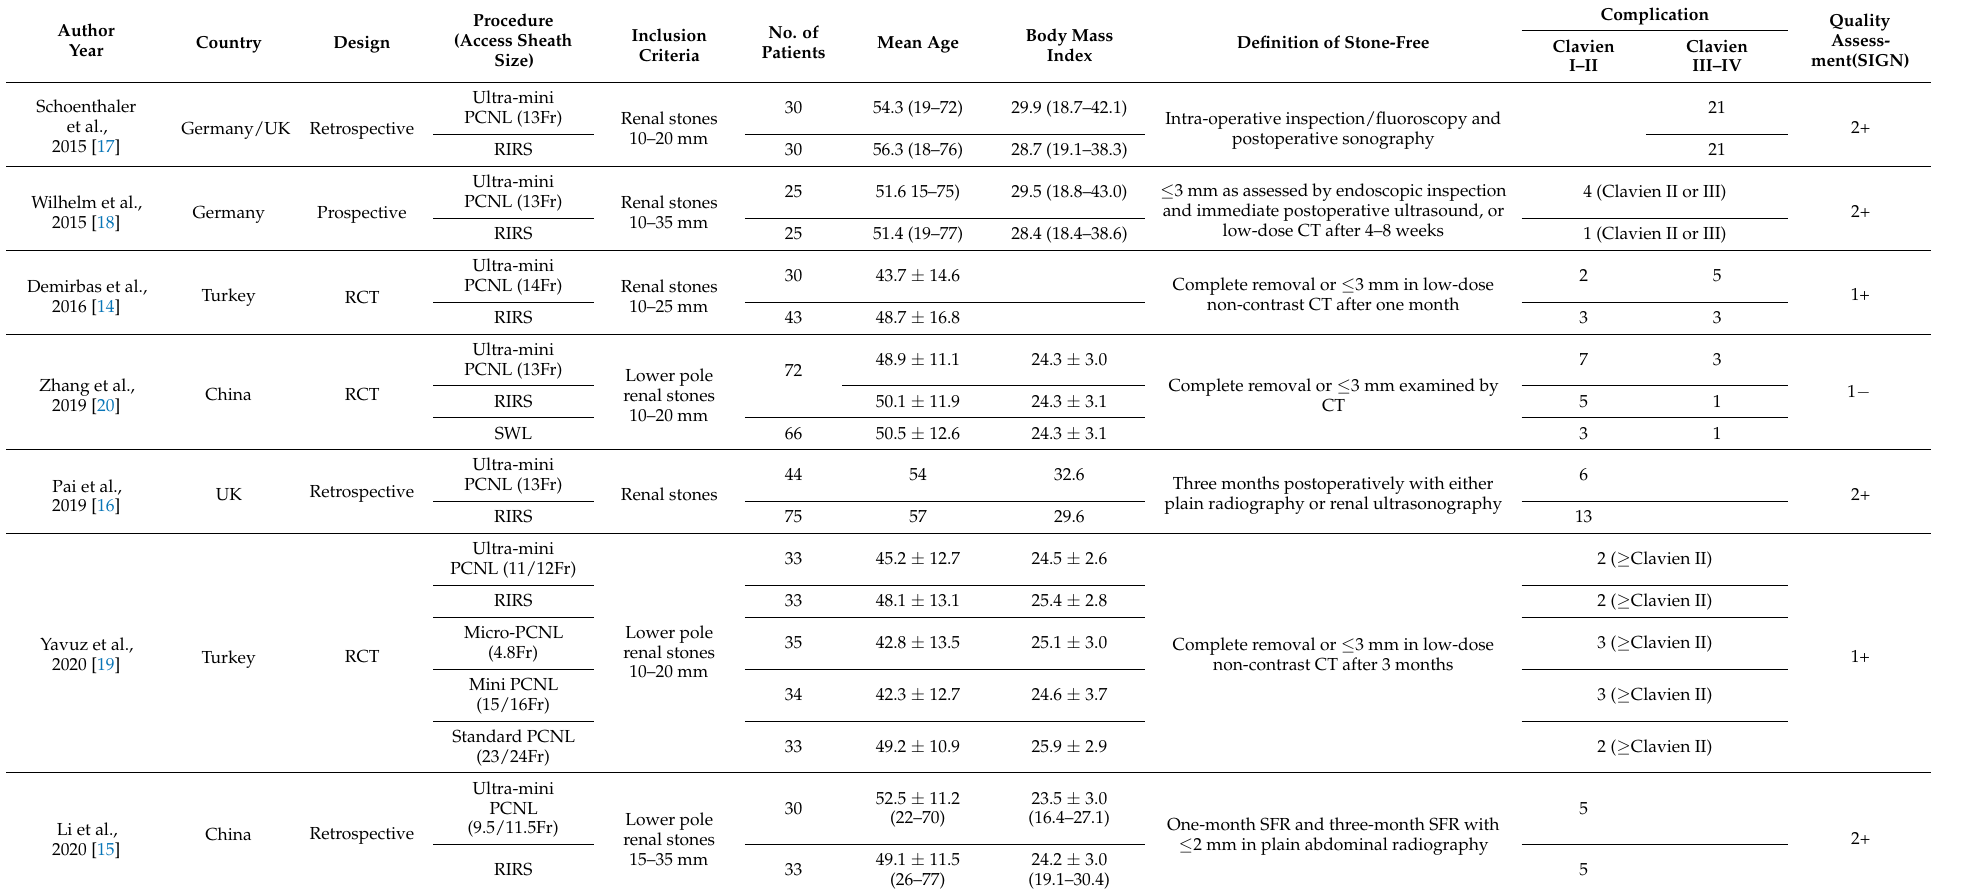
Table 1. Characteristics of the included